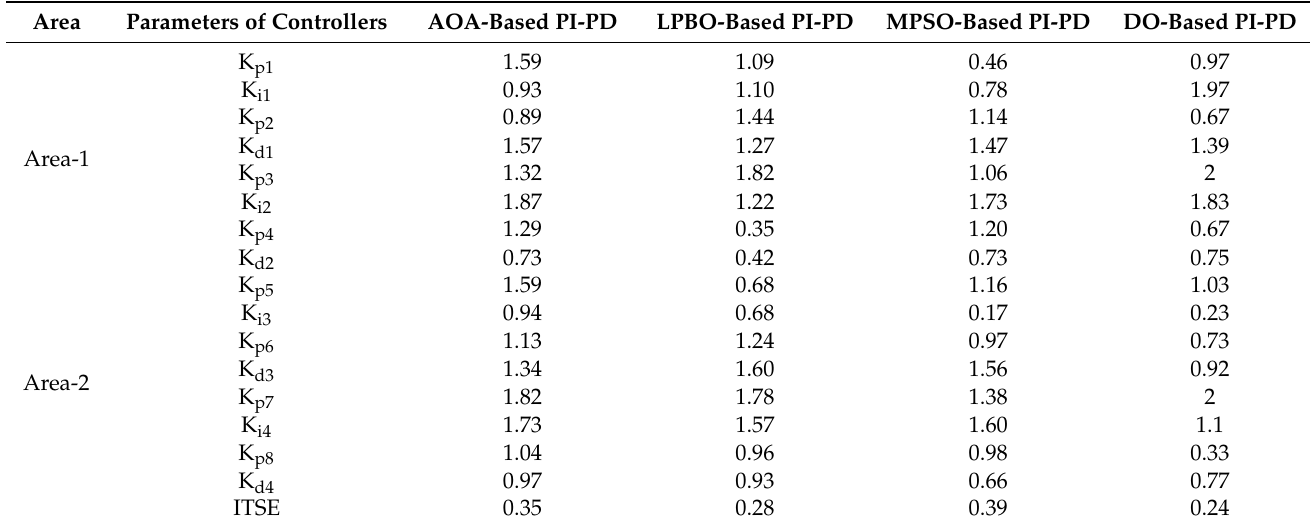
Table 4. Optimal controller parameters for a two-area multi-source